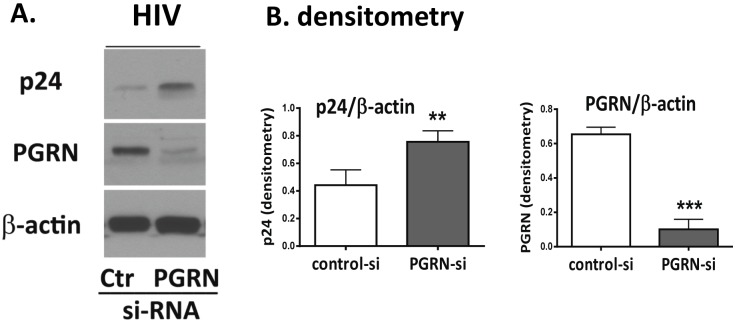
PGRN is an endogenous anti-HIV factor.Microglial PGRN was knocked down using RNAi 2–4 days prior to VSVg env HIV exposure as described in the Materials and Methods. Control cultures were treated with control, irrelevant siRNA (Ctr). The amounts of HIV (p24) and PGRN expression were determined by western blot analyses. (A) A representative western blot showing suppression of PGRN and increase of p24 following PGRN siRNA treatment. (B) Pooled densitometry data from four independent experiments showing significant inhibition of PGRN and increase of HIV (gag p24 express) in microglial cells treated with PGRN siRNA (vs. control siRNA). **P<0.01, ***P<0.001 by paired t-test.